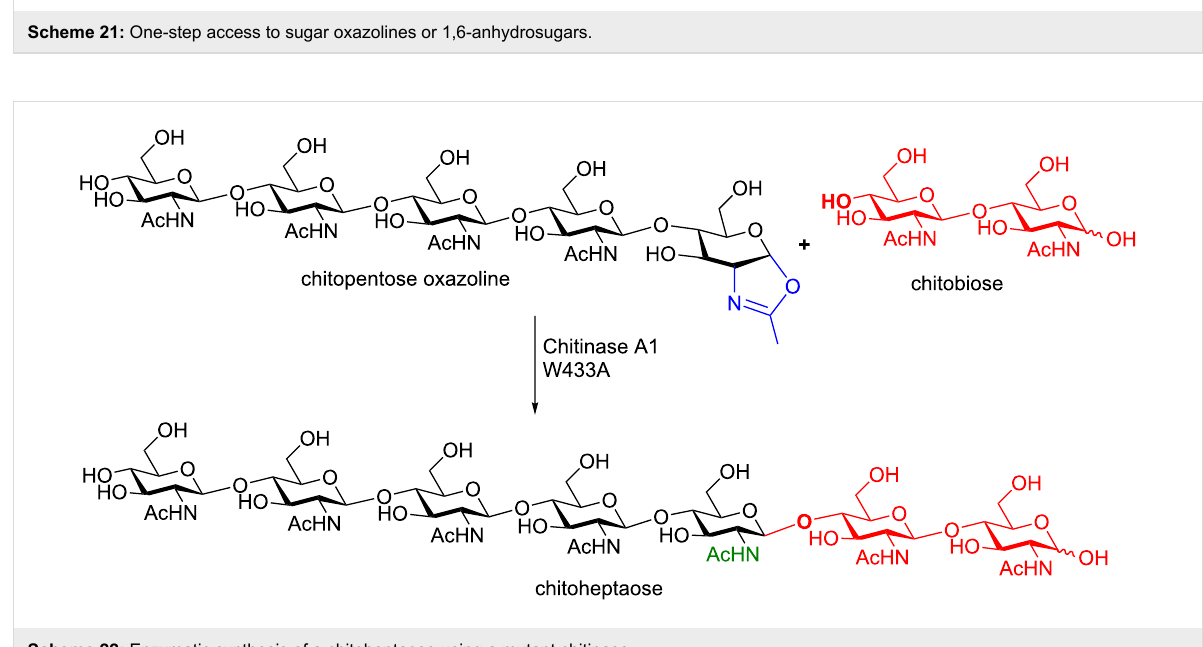
Scheme 22: Enzymatic synthesis of a chitoheptaose using a mutant